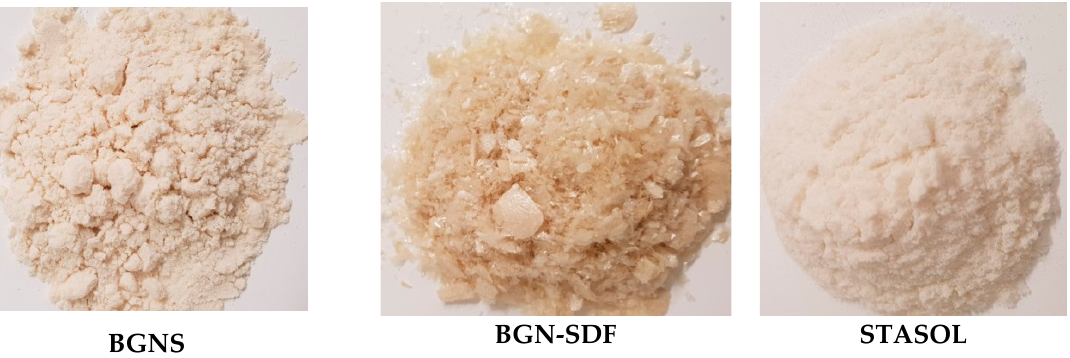
Figure 2. Pictorial representation of BGNS, BGN-SDF and STASOL. BGNS = Bambara groundnut starch; BGN-SDF = Bambara groundnut soluble dietary fibre; STASOL = Bambara groundnut starch–fibre nanocomposite.